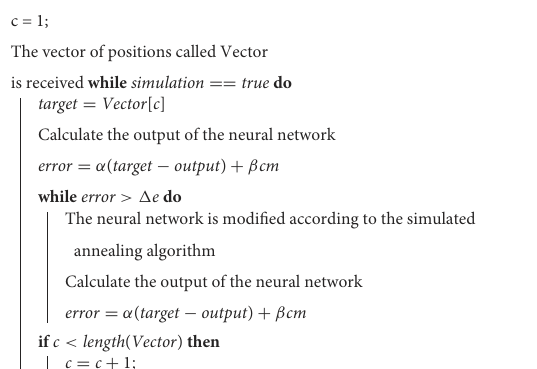
Algorithm 3 Learning algorithm in Simulink.